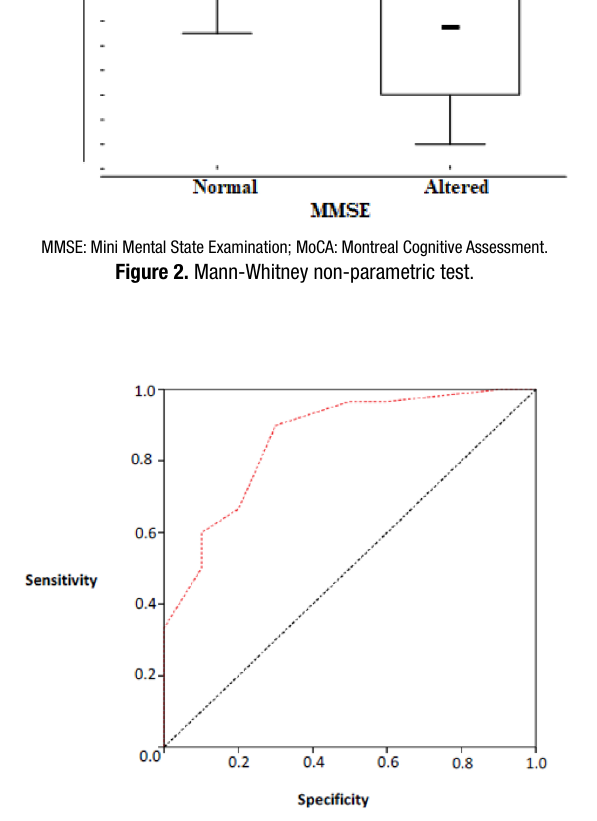
Figure 3. ROC Curve adjusted (area